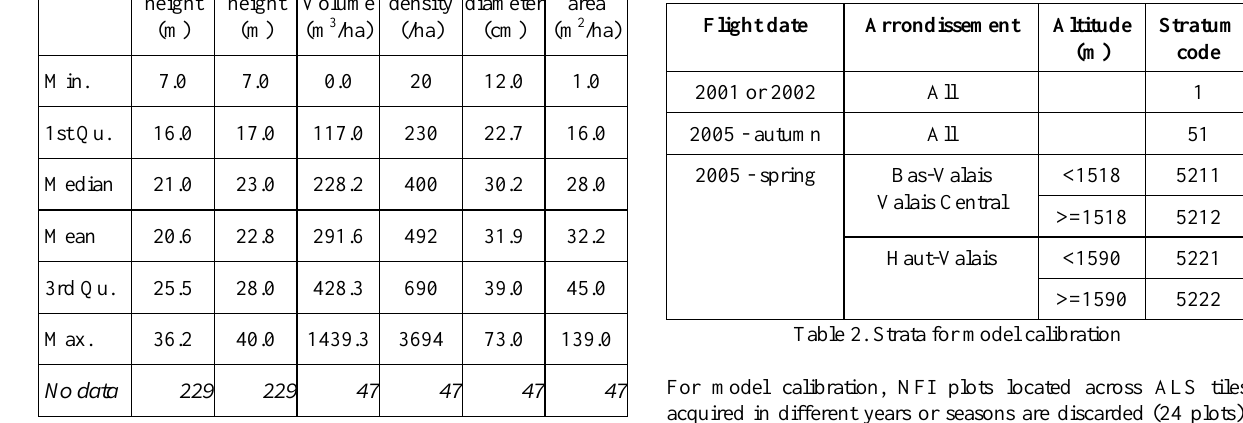
Table 1. Forest parameters statistics for the 688 NFI plots